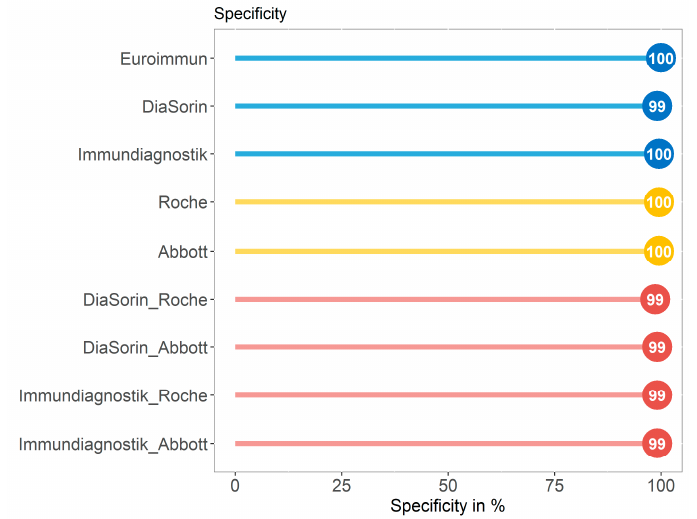
Figure 6. The specificity achieved by assays against the S (spike) protein (blue), the NC (nucleocapsid) antigen (yellow), and the combination of assays targeting the different proteins (red) for group C.